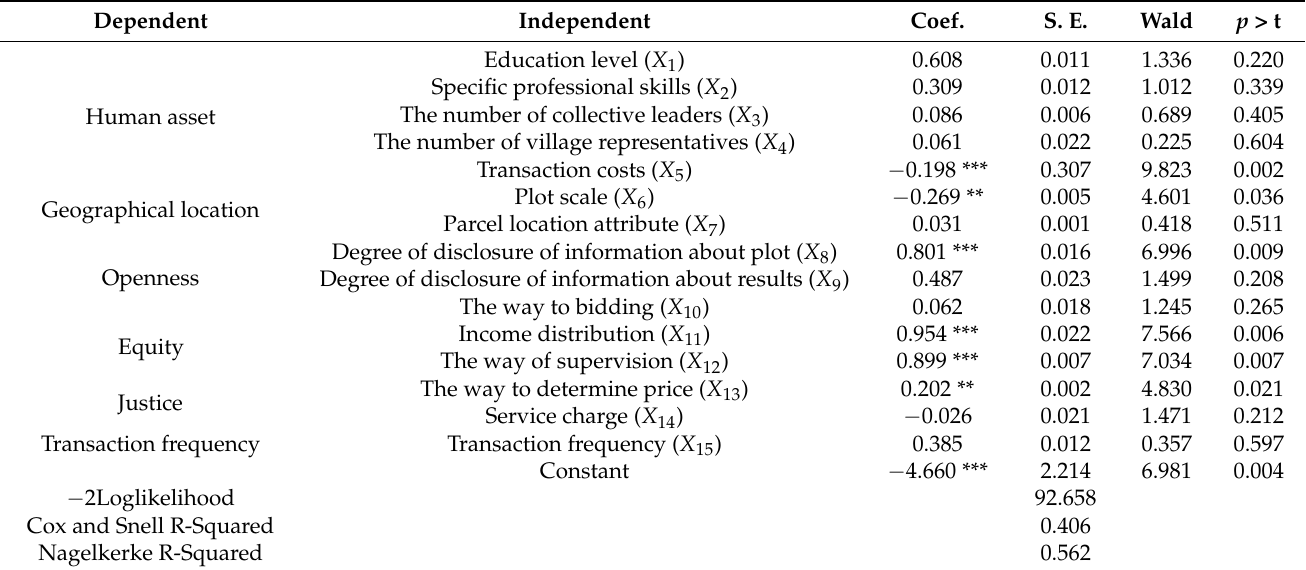
Table 2. The results of influence